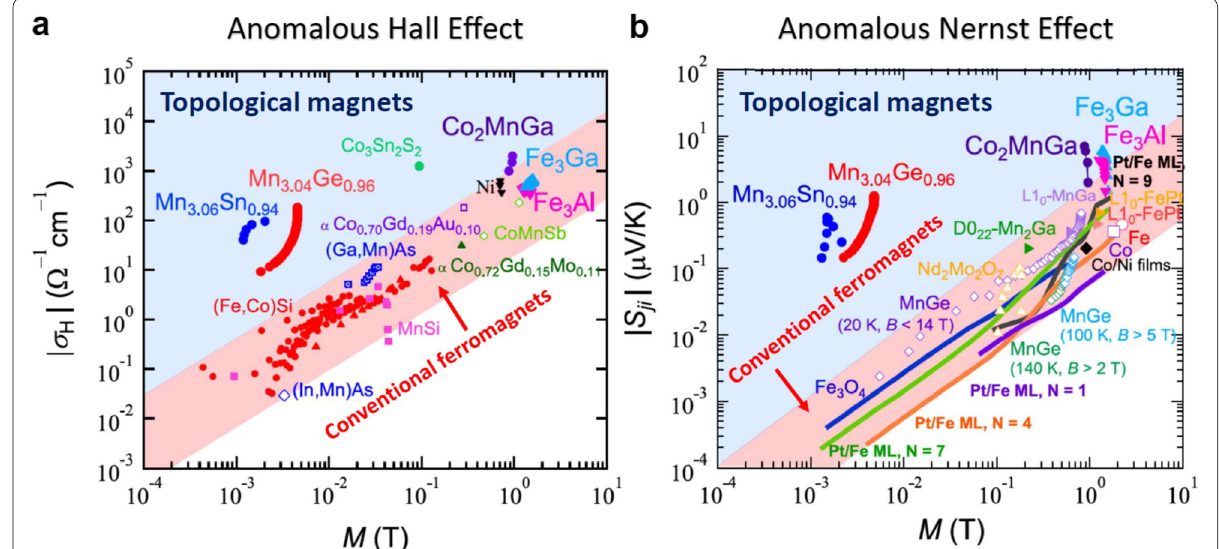
Fig. 2 A giant anomalous Hall effect and anomalous Nernst effect observed in topological magnets [20]. a Magnetization M dependence of the anomalous Hall conductivity σ H of various ferromagnets. Hall conductivity σ H of conventional ferromagnets is observed to increase in proportion to magnetization M (red belt). The Hall conductivity of Weyl magnets such as Mn 3 Sn, Mn 3 Ge, Co 3 Sn 2 S 2 , and Co 2 MnGa is at least an order of magnitude higher than the value predicted by the scaling law (red belt) of ferromagnets. b Relationship between the Nernst coefficient S ji and magnetization M for various ferromagnets. All the data falls roughly into the red belt, indicating that the Nernst coefficient increases in proportion to the magnetization. The measurement results of the antiferromagnets Mn 3 Sn and Mn 3 Ge for various magnetic field directions and temperatures are shown; in addition to not following the conventional scaling relation, their Nernst coefficients are almost the same magnitude as the highest values known for ferromagnets. The Weyl ferromagnet Co 2 MnGa and the nodal-line semimetals, Fe 3 Ga and Fe 3 Al, also take values an order of magnitude greater than a conventional ferromagnet (red